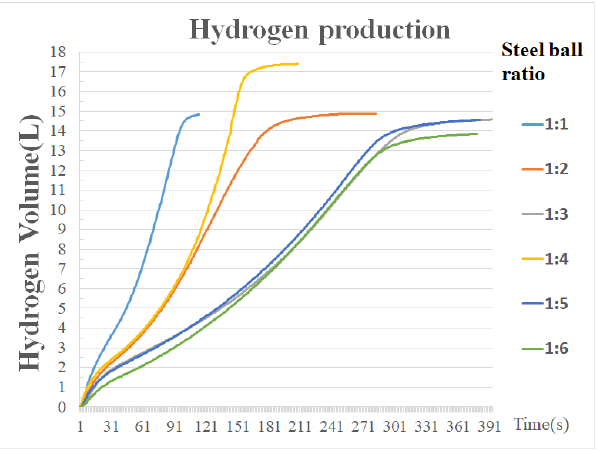
Figure 5. Comparison of hydrogen production rates of ball milling steel ball in different ratios.